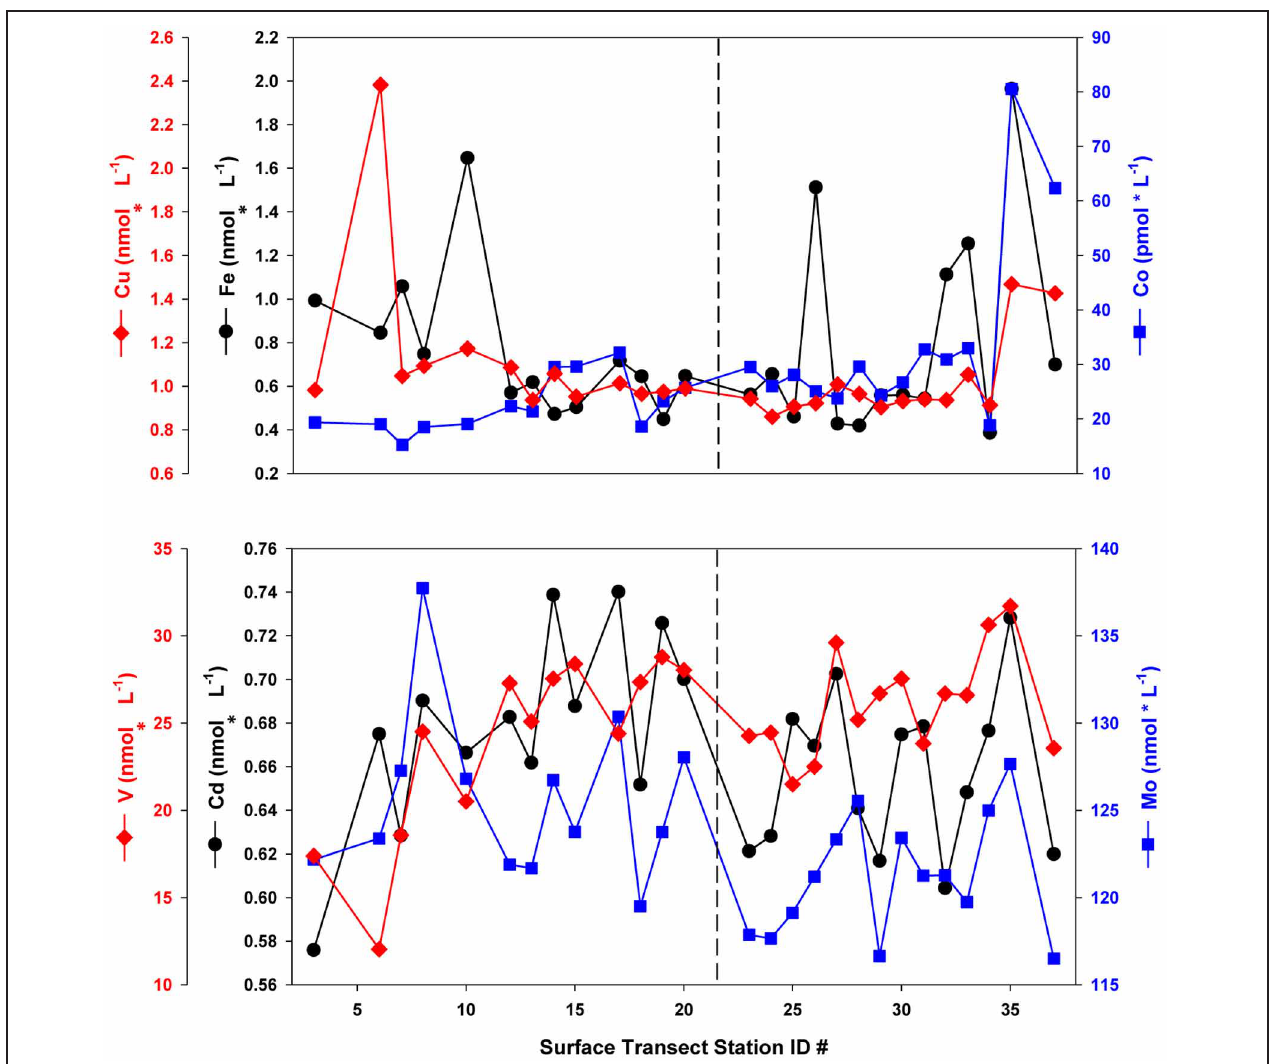
FIGURE 2 | Dissolved trace metal concentrations along the NASB transect (depth = 10m). Vertical dashed line separates the Southern (left panel, stations 1–23) from Northern transect (right panel, stations 24–37) sections.